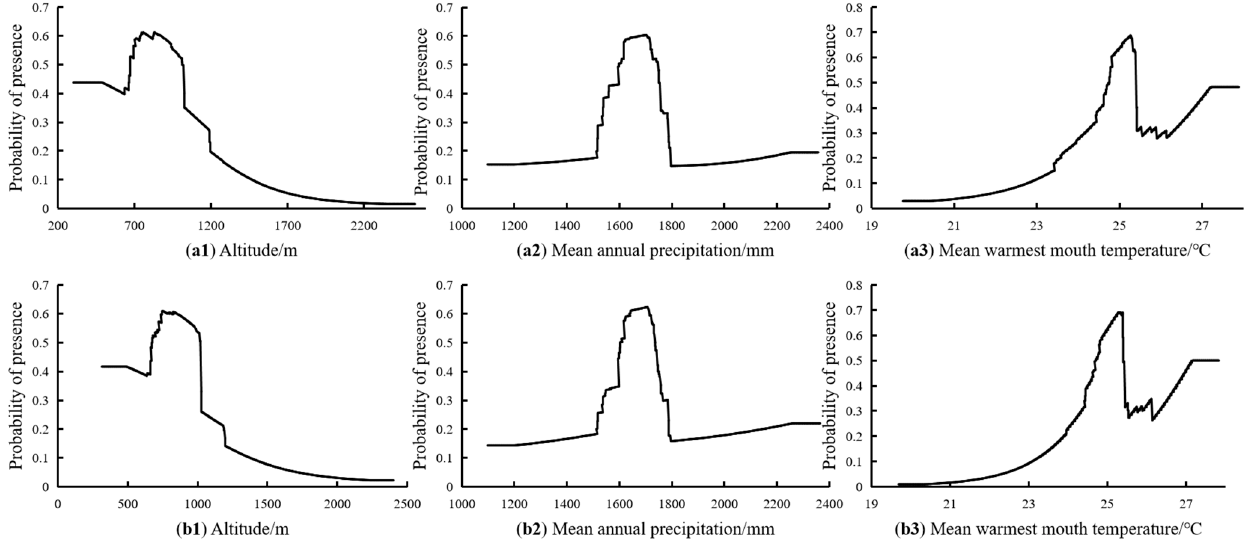
Figure 5. The response curves of the dominant environmental variables affecting the distribution of Asian elephants in Sipsongpanna. Effects of altitude, mean annual precipitation, and mean warmest month temperature on the distribution of Asian elephants under NAI (Non-anthropogenic Interfer- ence, ( a1 – a3 )) and under AI (Anthropogenic Interference, ( b1 – b3 )).